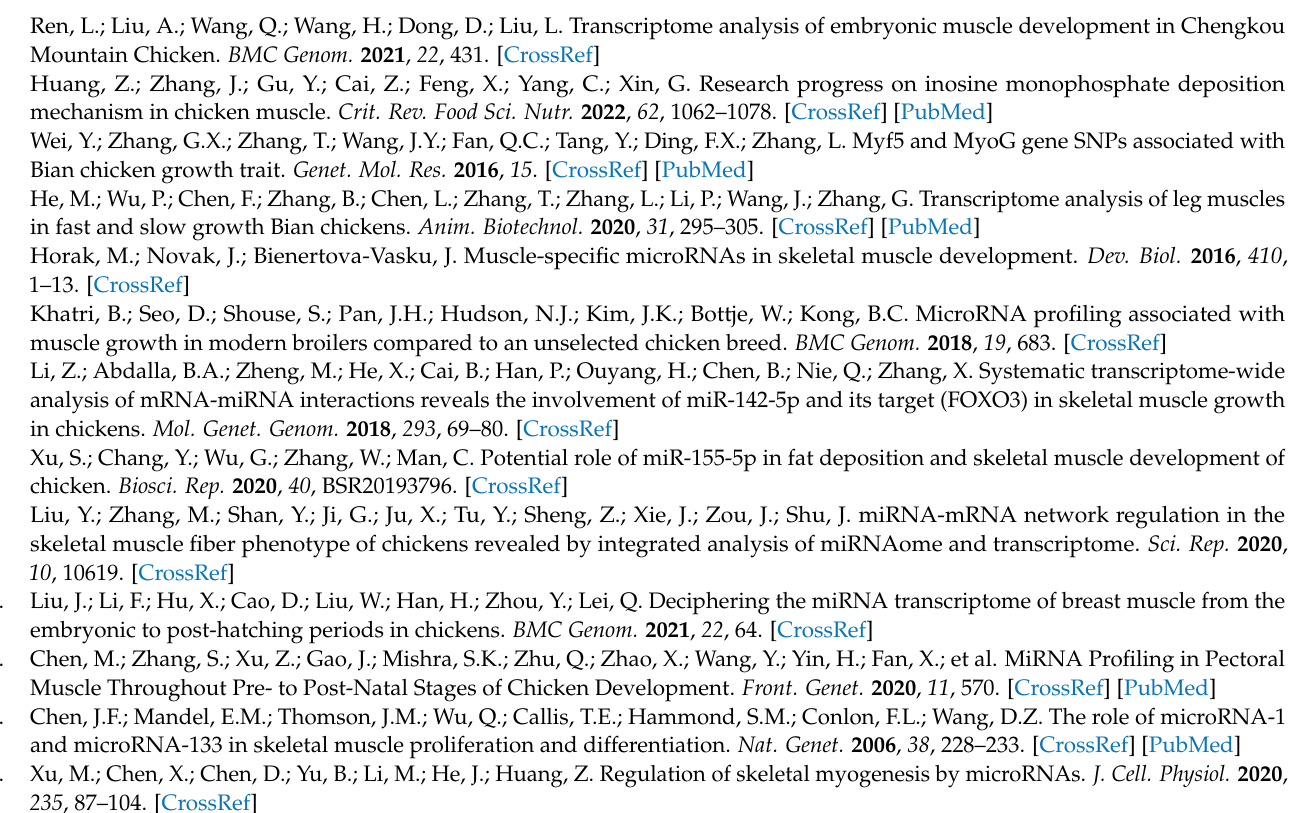
qPCR; Table S2: Differentially expressed miRNAs in F14 vs. F20 comparison group; Table S3: Differentially expressed miRNAs in S14 vs. S20 comparison group; Table S4: Differentially expressed miRNA-gene in F14 vs. F20; Table S5: Differentially expressed miRNA-gene in S14 vs. S20; Table S6: GO enrichment of F14 vs. F20; Table S7: GO enrichment of S14 vs. S20; Table S8: KEGG